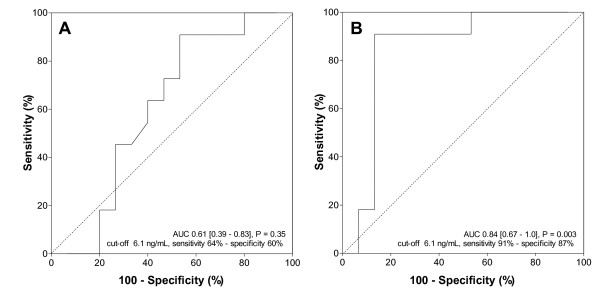
Prediction of inhalation trauma. Receiver operating characteristic (ROC) curve comparing the ability of (a) systemic and (b) pulmonary levels of suPAR to discriminate between the presence or absence of inhalation trauma in mechanically ventilated patients by using a cut-off value of 6.1 ng/ml. The AUC, the P value, the sensitivity, and the specificity are given in each panel.